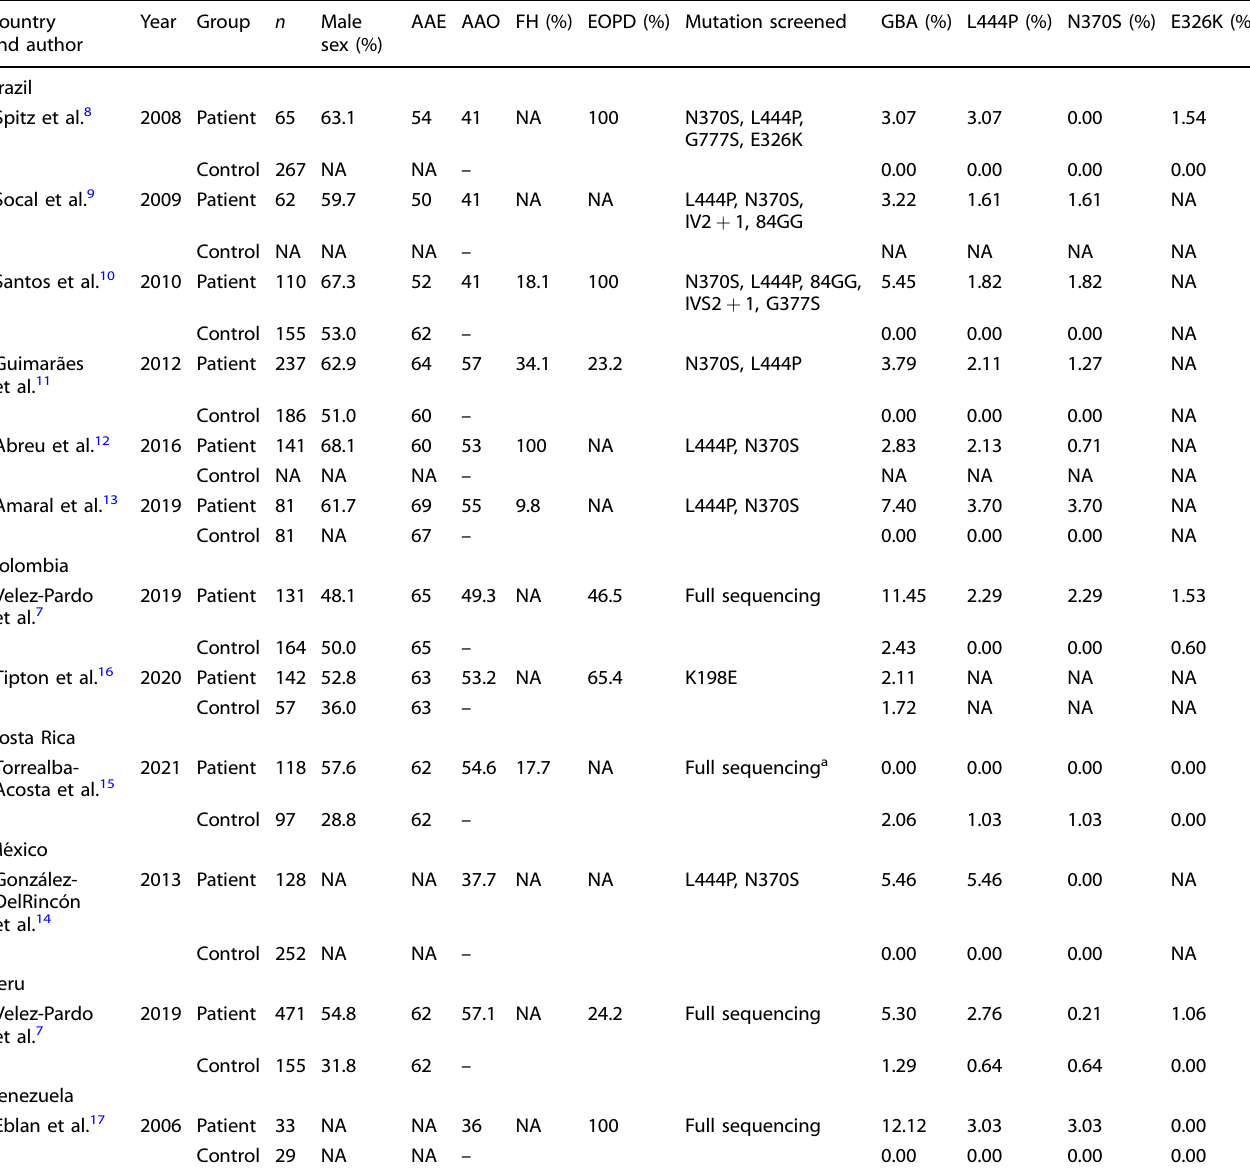
Table 1. Main characteristics of studies and frequencies of GBA1 pathogenic variants (plus p.E326K) in patients with PD and controls included in the meta-analysis. Country and